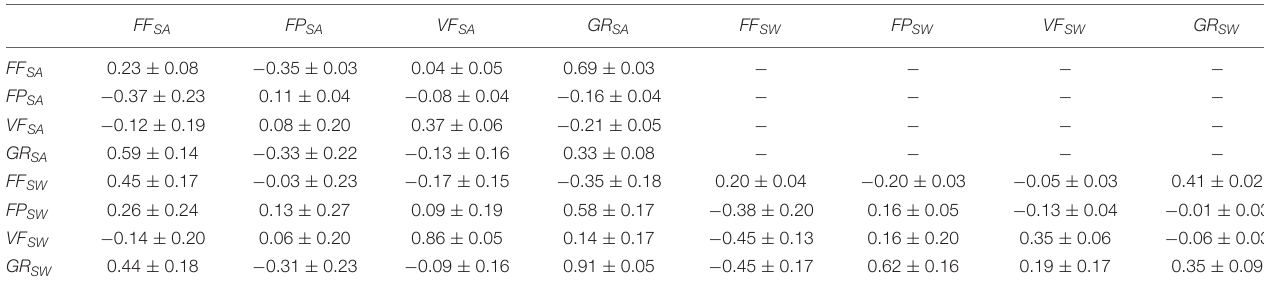
TABLE 3 | Estimates of heritability of the studied traits (on the diagonal) and genetic (below the diagonal) and residual (above the diagonal) correlations between the traits based on the data from both year